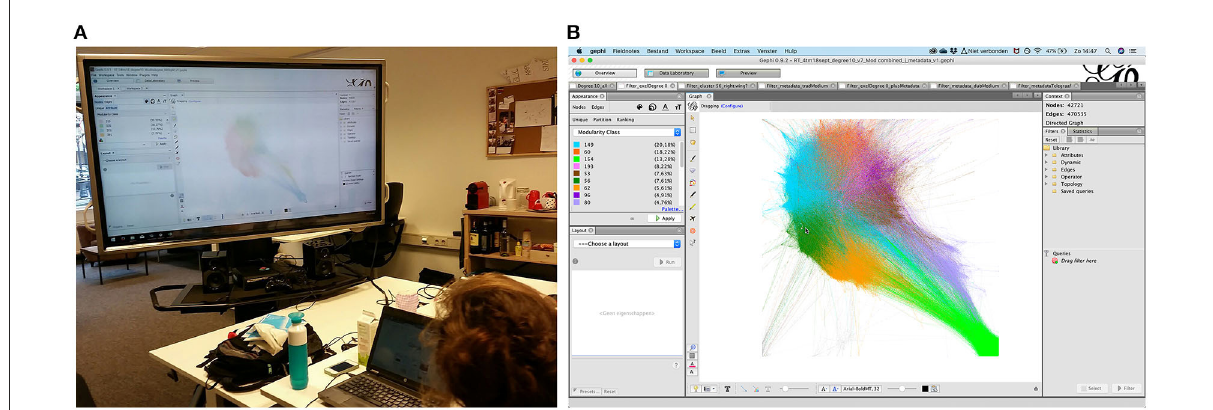
FIGURE2 (A, B) Exploration and mapping of Dutch-speaking Twitter users as part of a collaboration between media researchers and journalists conducted by Daniela van Geenen and Maranke Wieringa at the office of the Datafied Society research platform. The photograph shows the construction of the retweet network in August 2017 on a large screen (left). The screenshot zooms in on the spatialized and filtered network graph of the same retweet network in Gephi’s interface with the cursor pointing to the politically right-wing cluster (community 56)